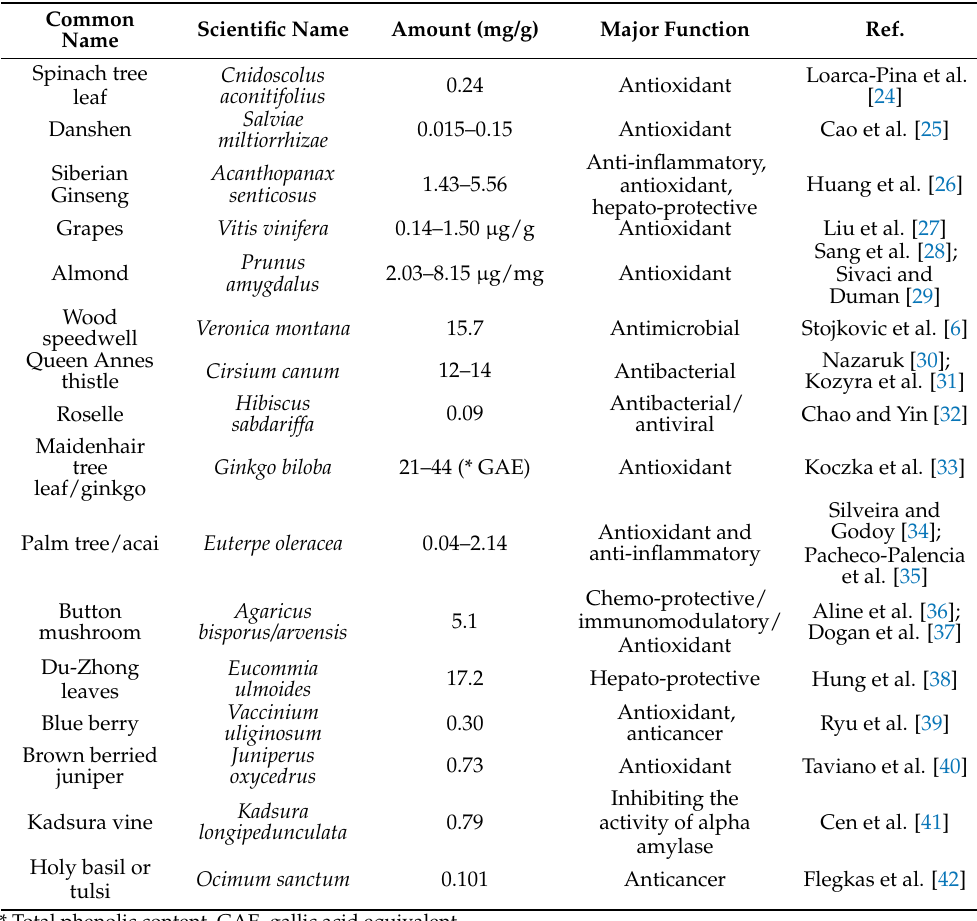
Table 1. Common plant sources of protocatechuic acid.